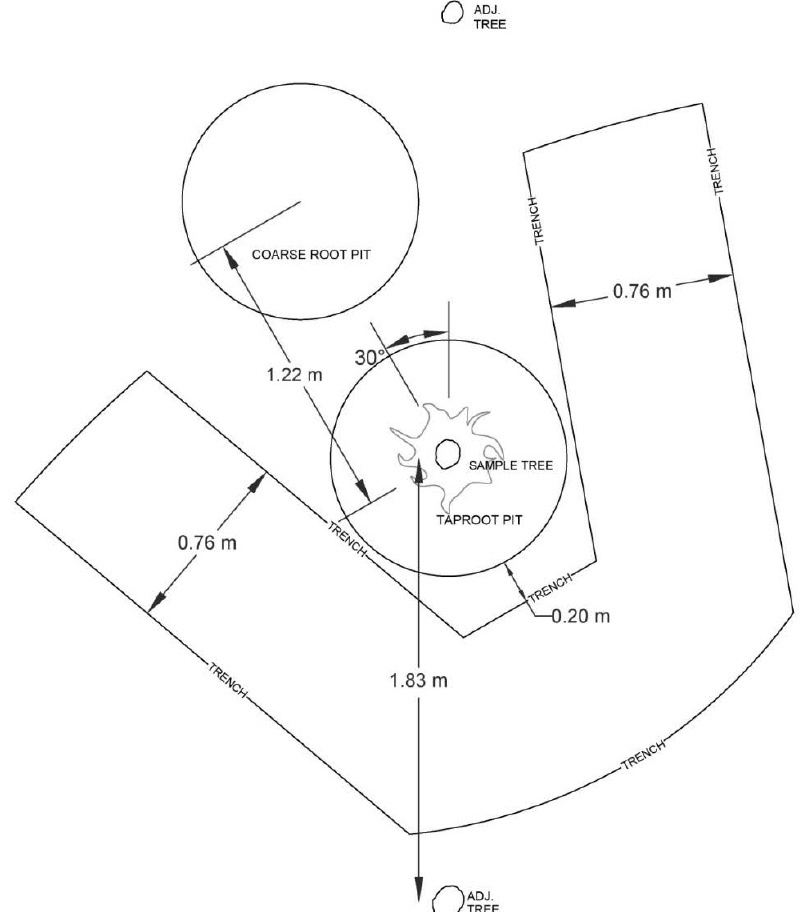
Figure 2. Representation of trench excavation methods. Location of 1 meter diameter taproot and coarse root sample pits relative to the sample tree. Trench excavation conducted by John Deere 310SJ backhoe loader with approximate minimum clearance of 0.2 m. This belowground sampling procedure was designed for planted stands on 1.83 meter within-row